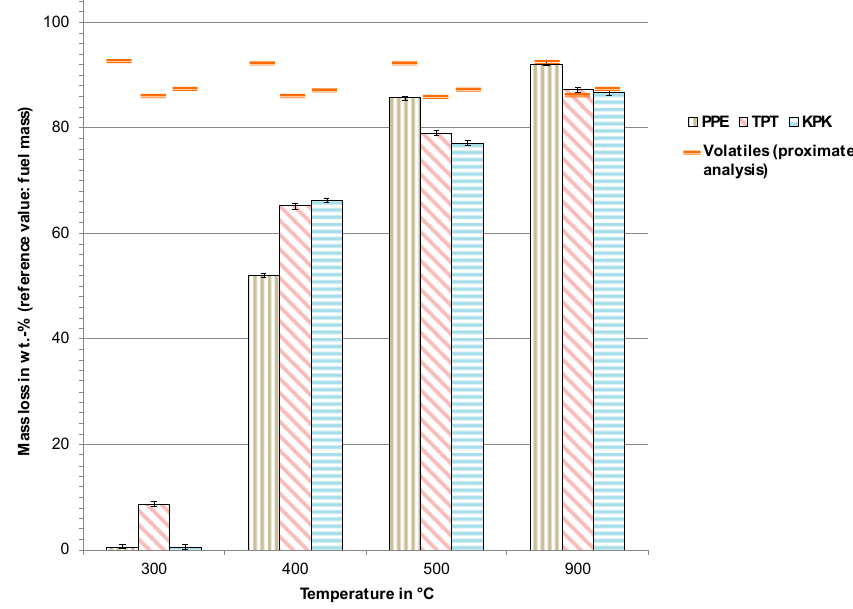
Figure 3. Mass loss from the pyrolysis of PPE, TPT, and KPK at various temperatures.